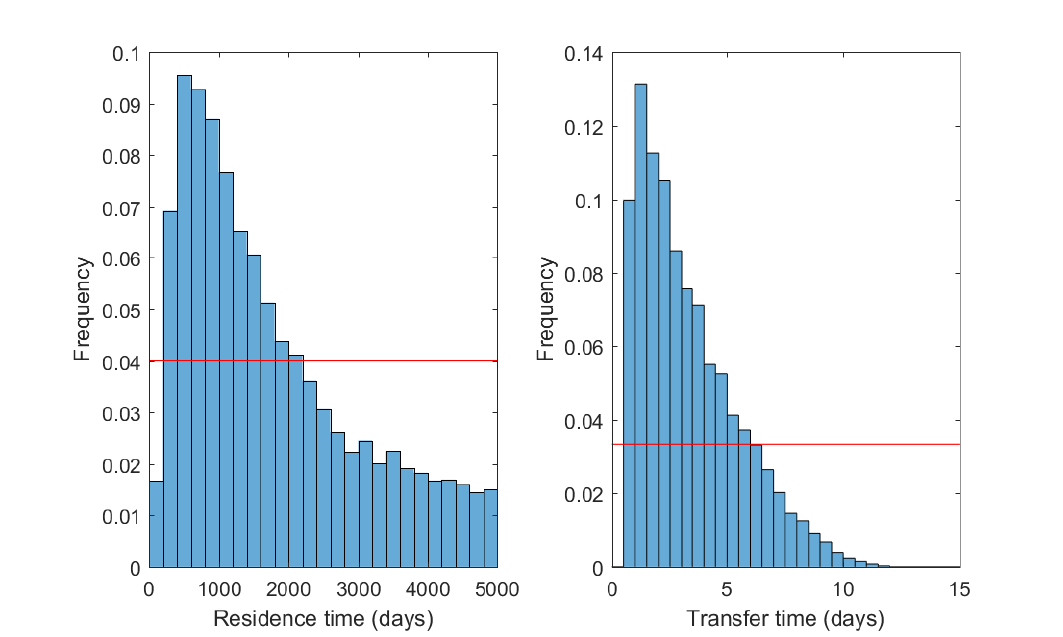
Figure 6. Histograms of the dynamic parameters ( τ and θ ) for which the model can explain the measurements. The horizontal bar represents the uniform law used to generate random values. See the caption of Figure 5 for further details.